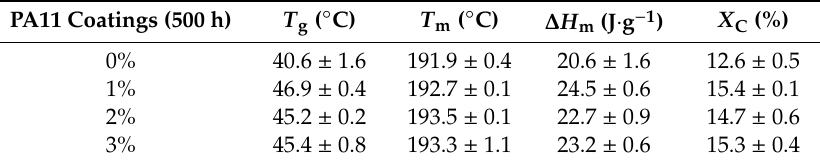
Table 3. Thermal properties of the organic coatings after xenon exposure.